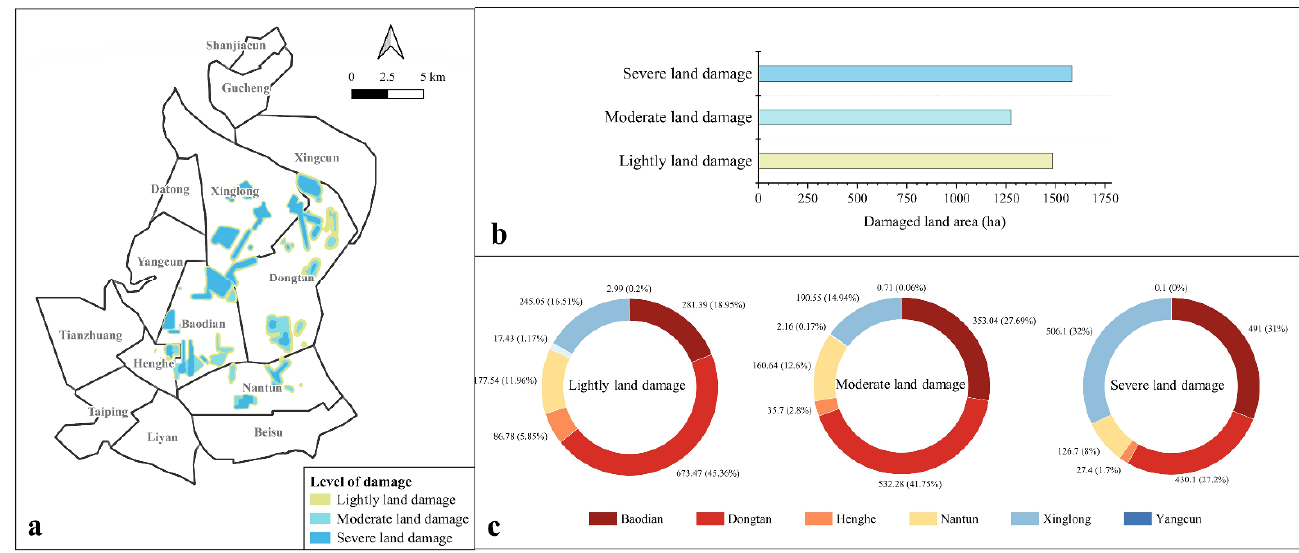
Figure 5. Predicting outcomes of land damage in 2030: ( a ) spatial distribution of damage; ( b ) area proportion of different coal mines with varying degrees of damage; ( c ) area statistics for various degrees of damage).